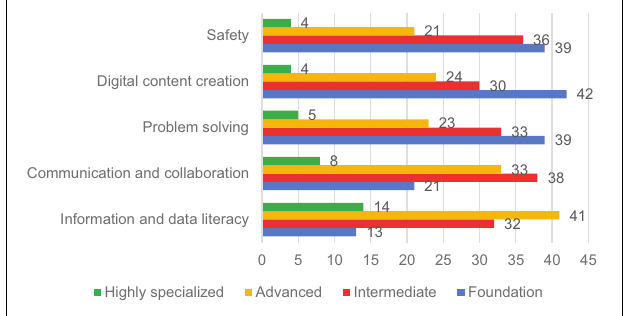
FIGURE 1 | Competence areas and proficiency levels in